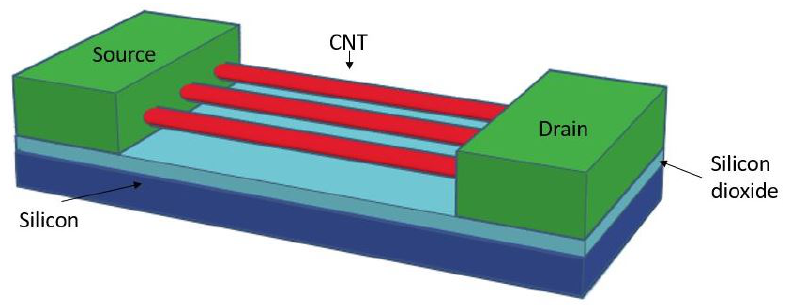
Figure 9. Structure of the